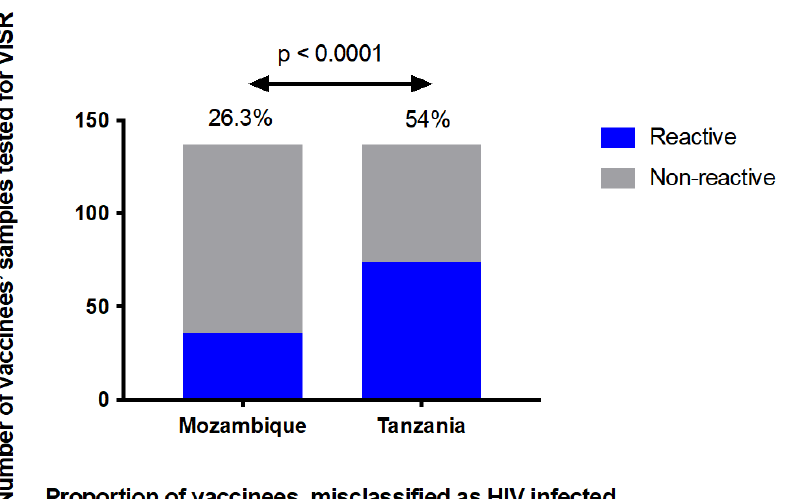
Figure 2. Proportion of vaccinees misdiagnosed as HIV-infected. Samples were tested for VISR using HIV testing algorithms used in Mozambique and Tanzania that use two sequential rapid diagnostic tests: Alere Determine TM HIV-1/2 and Uni-Gold TM HIV-1/2 in Mozambique, SD Bioline HIV1/2 3.0 and Uni-Gold TM HIV-1/2 in Tanzania. Patients were considered HIV-negative if the screening assay was negative and HIV-infected if both assays were reactive. Fisher’s exact test was used to compare the frequency of VISR between the two HIV testing algorithms. The proportion of vaccine recipients who would have been misclassified using the Mozambican HIV testing algorithm was half of that misclassified by the Tanzanian algorithm.